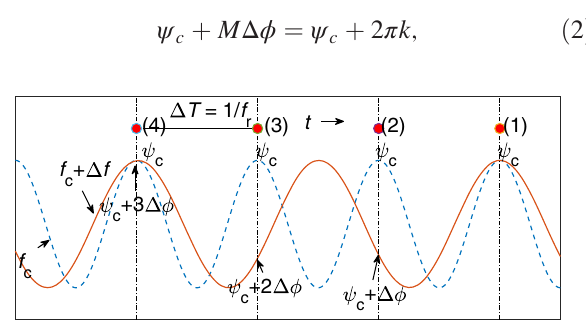
FIG. 2. Acceleration phase changes of the CW electron beams by the off-frequency detune of the SRF cavities. Here we use M ¼ 3 and acceleration phase of the fourth beam is the same with the first